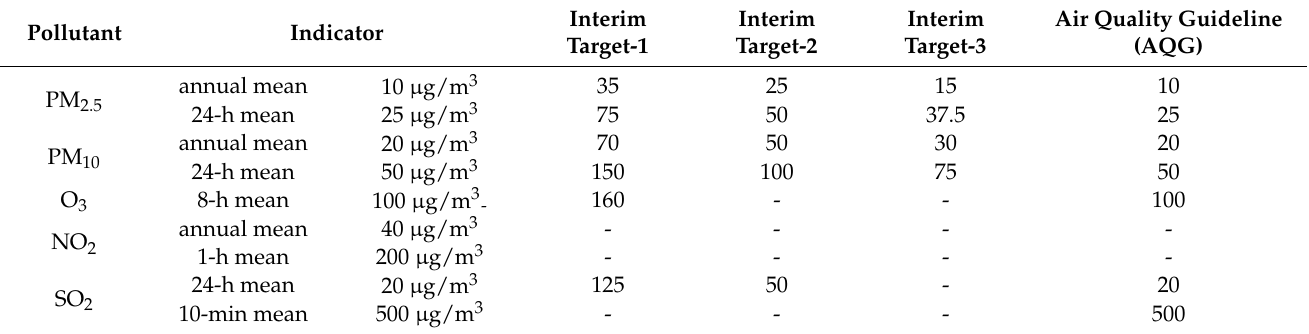
Table 2. Air quality indicators of typical air